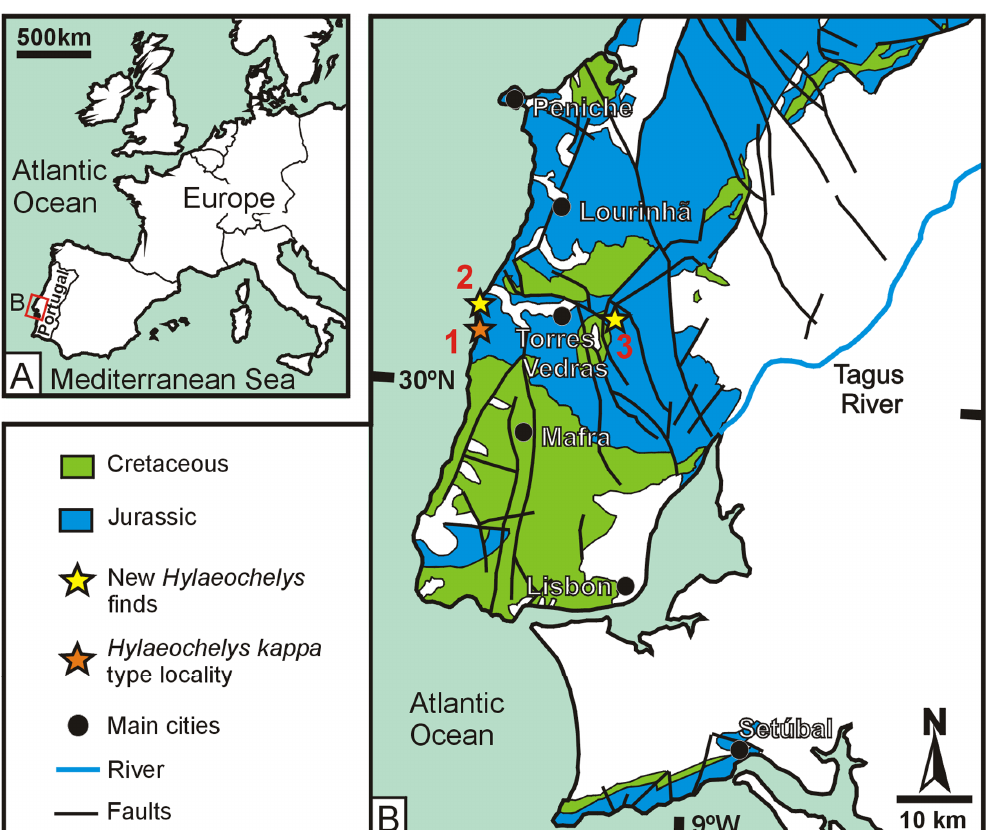
Figure 1. Location of the finds of the thalassochelydian turtle Hylaeochelys in Portugal, all of them from Upper Jurassic outcrops (middle to late Tithonian Freixial Formation) of the Lisbon District, in the Lusitanian Basin (west-central Portugal). ( A ), location of the southern half of the Lusitanian Basin (red rectangle) in a geographic map of Europe. ( B ), map of the southern half of the Lusitanian Basin showing the main Jurassic and Cretaceous areas, and the position of the outcrops in which remains attributable to Hylaeochelys kappa have been found: 1, type locality of the species (Barril, Encarnação Civil Parish, Mafra Municipality); 2, Cambelas (São Pedro da Cadeira Civil Parish, Torres Vedras Municipality), where the specimen SHN 025 was found; 3, Zibreira (Carvoeira Civil Parish, Torres Vedras Municipality), where SHN 026 was discovered.